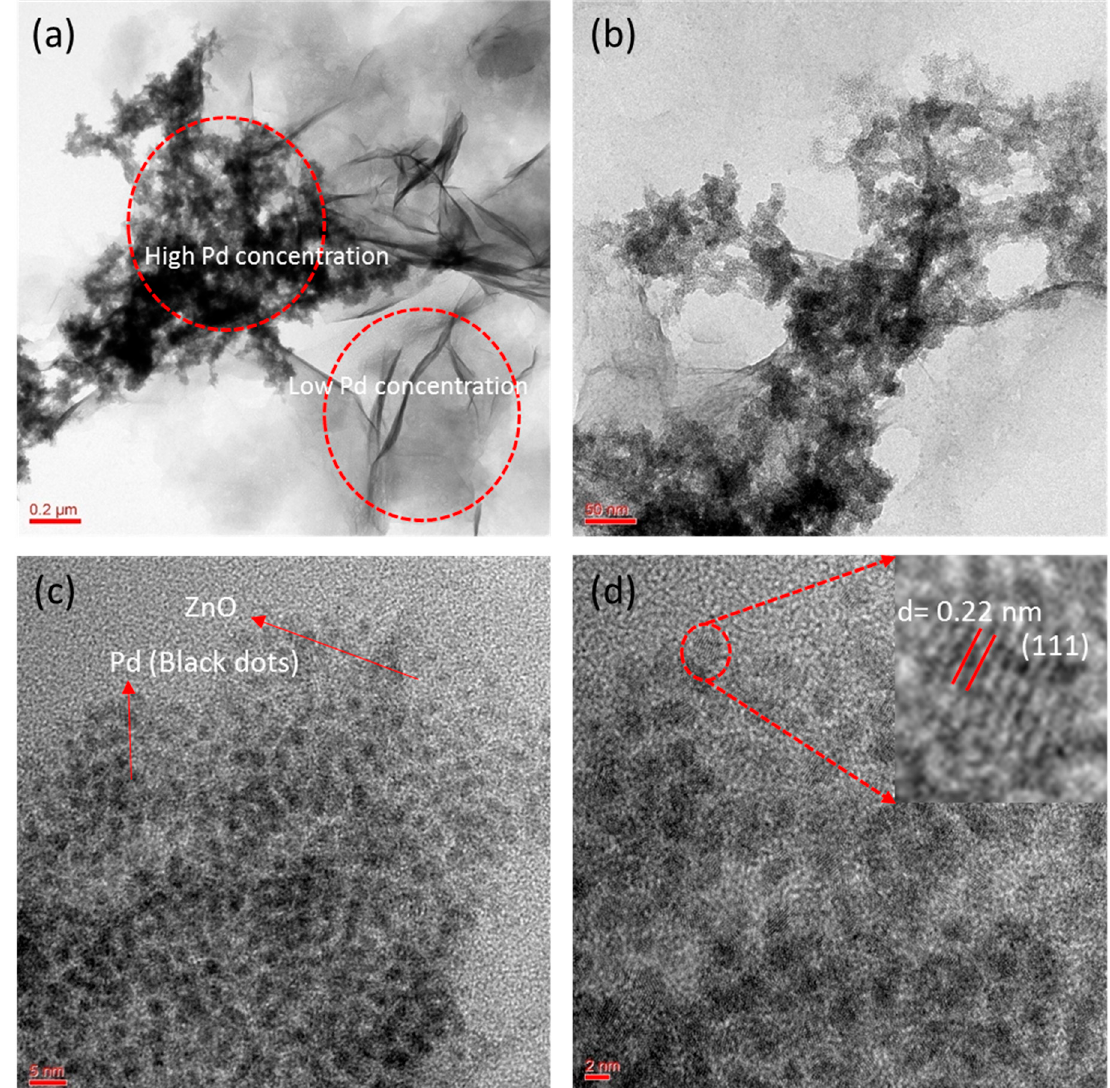
Figure 3. Transmission electron microscopy (TEM) images of biosynthesized ZnO-Pd nanosheets. ( a ) Overall view of sample. ( b ) Magnified view of nanosheets. ( c ) High-resolution (HR) TEM micrographs. ( d ) HR-TEM micrograph showing the crystalline nature (the inset shows the d-spacing of the palladium nanoparticles).